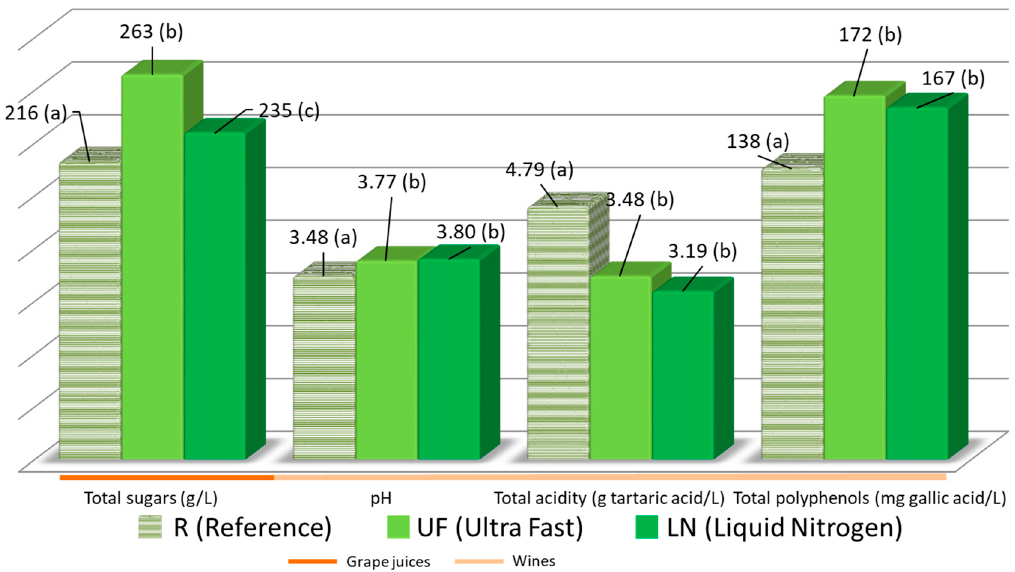
Figure 2. Average levels or the routine parameters in the different grape juices and wines (R, UF and LN). Different letters in brackets indicate a significant difference ( p -value < 0.05) for each parameter.